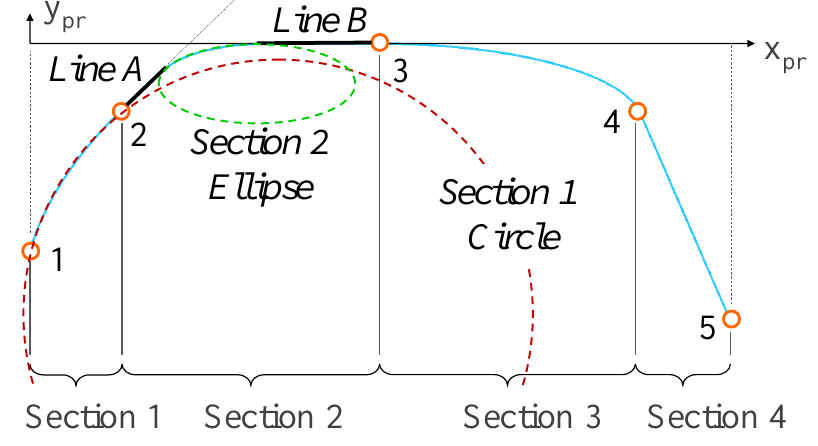
Figure 12. Interpolation scheme